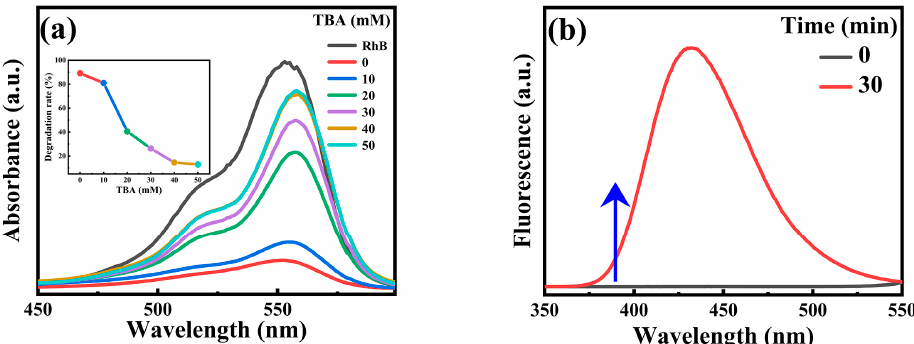
Figure 3. ( a ) The effect of different doses of TBA on the degradation of RhB solution by the elbaite/H 2 O 2 system. ( b ) The ·OH capture spectra of suspension containing elbaite and TA were studied at a 315 nm photoluminescence excitation wavelength. Experimental conditions: RhB = 100 mg/L, elbaite dose = 4.0 g/L, H 2 O 2 dose = 7.0 mL/L, initial pH = 2.0, T = 30 °C–80 °C, time = 10 min, 30 min.